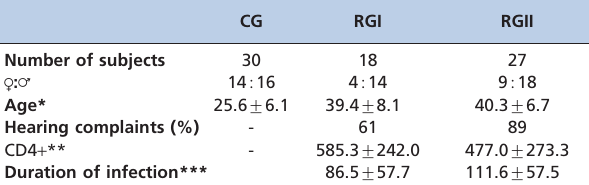
Table 1 - Descriptive analysis of the Control Group, Research Group I, and Research Group II regarding gender, age, hearing complaints, CD4 + T lymphocytes and the duration of HIV infection.